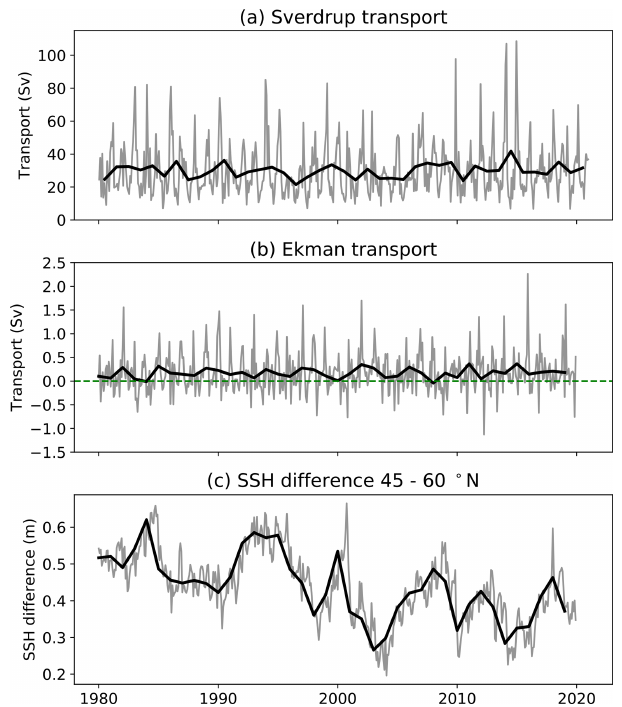
Figure 6. Annual and monthly mean eastward volume transport time series: (a) Sverdrup transport calculated from NCEP winds; (b) Ekman transport calculated from GODAS northward momen- tum (wind) flux for the shelf-edge region (15 ◦ W, 50–58 ◦ N); (c) SSH difference between 45 and 60 ◦ N at 30 ◦ W.